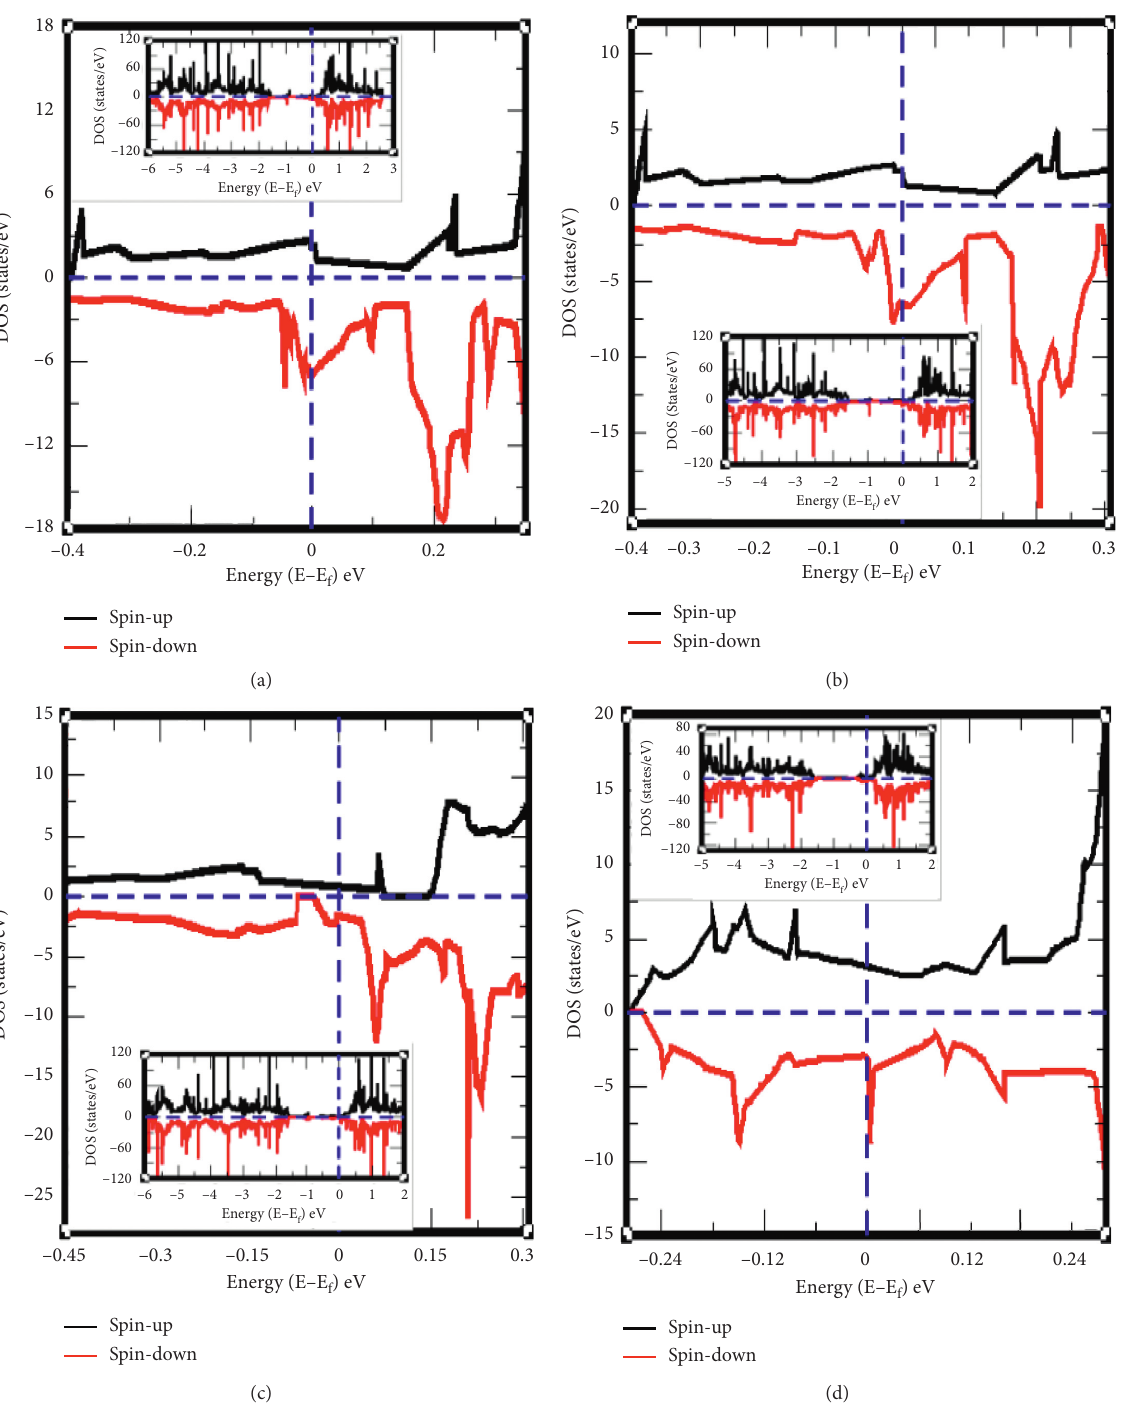
Figure 5: DOS plot of up and down states of spin electrons in the orbitals of C, Mo, and S atoms in (a) R-1C vacancy defects in HS-G/MoS material, (b) L-1C vacancy defects in HS-G/MoS 2 material, (c) C-1C vacancy defects in HS-G/MoS 2 material, and (d) 2C vacancy defects in HS-G/MoS 2 material, where the states above the horizontal dotted line represent spin-up electrons and a state below the horizontal dotted line represents spin-down